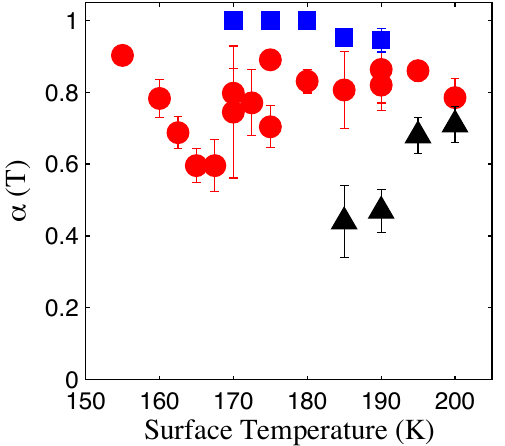
Fig. 3. The D 2 O uptake coefficient α(T ) calculated with TOF mea- surements for methanol covered ice (blue squares), butanol covered ice (red circles) and H 2 O uptake for the butanol covered ice at long times using bulk vapour pressure measurements (black triangles). Where not visible the error bars are subsumed by the data points. Section 2.2 describes the error analysis for the blue and red points, while the error of the black points is calculated directly by propa- gating the measurement